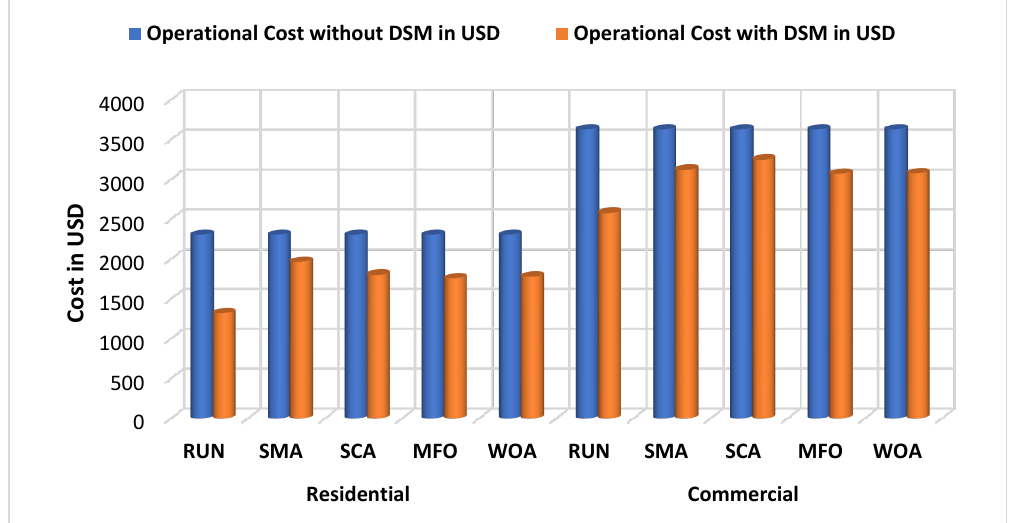
Figure 9. Operational cost reduction by strategic conservation.